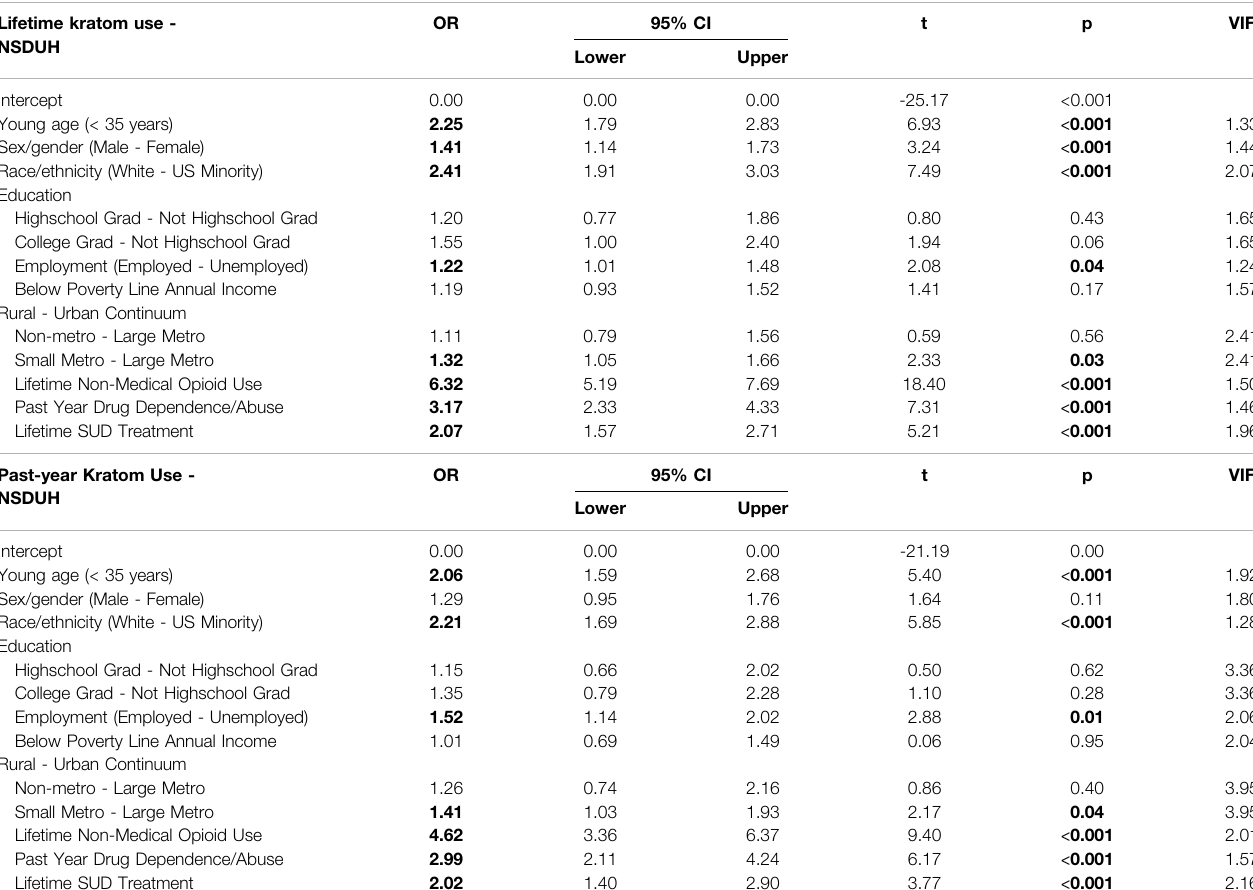
TABLE5| Survey-weightedmultiplelogisticregressionmodelsusingnationallyrepresentativeNSDUH2019datatoexaminetherelationshipbetweencountyresidenceand kratom use while controlling for demographic and substance use factors. Lifetime kratom use - NSDUH